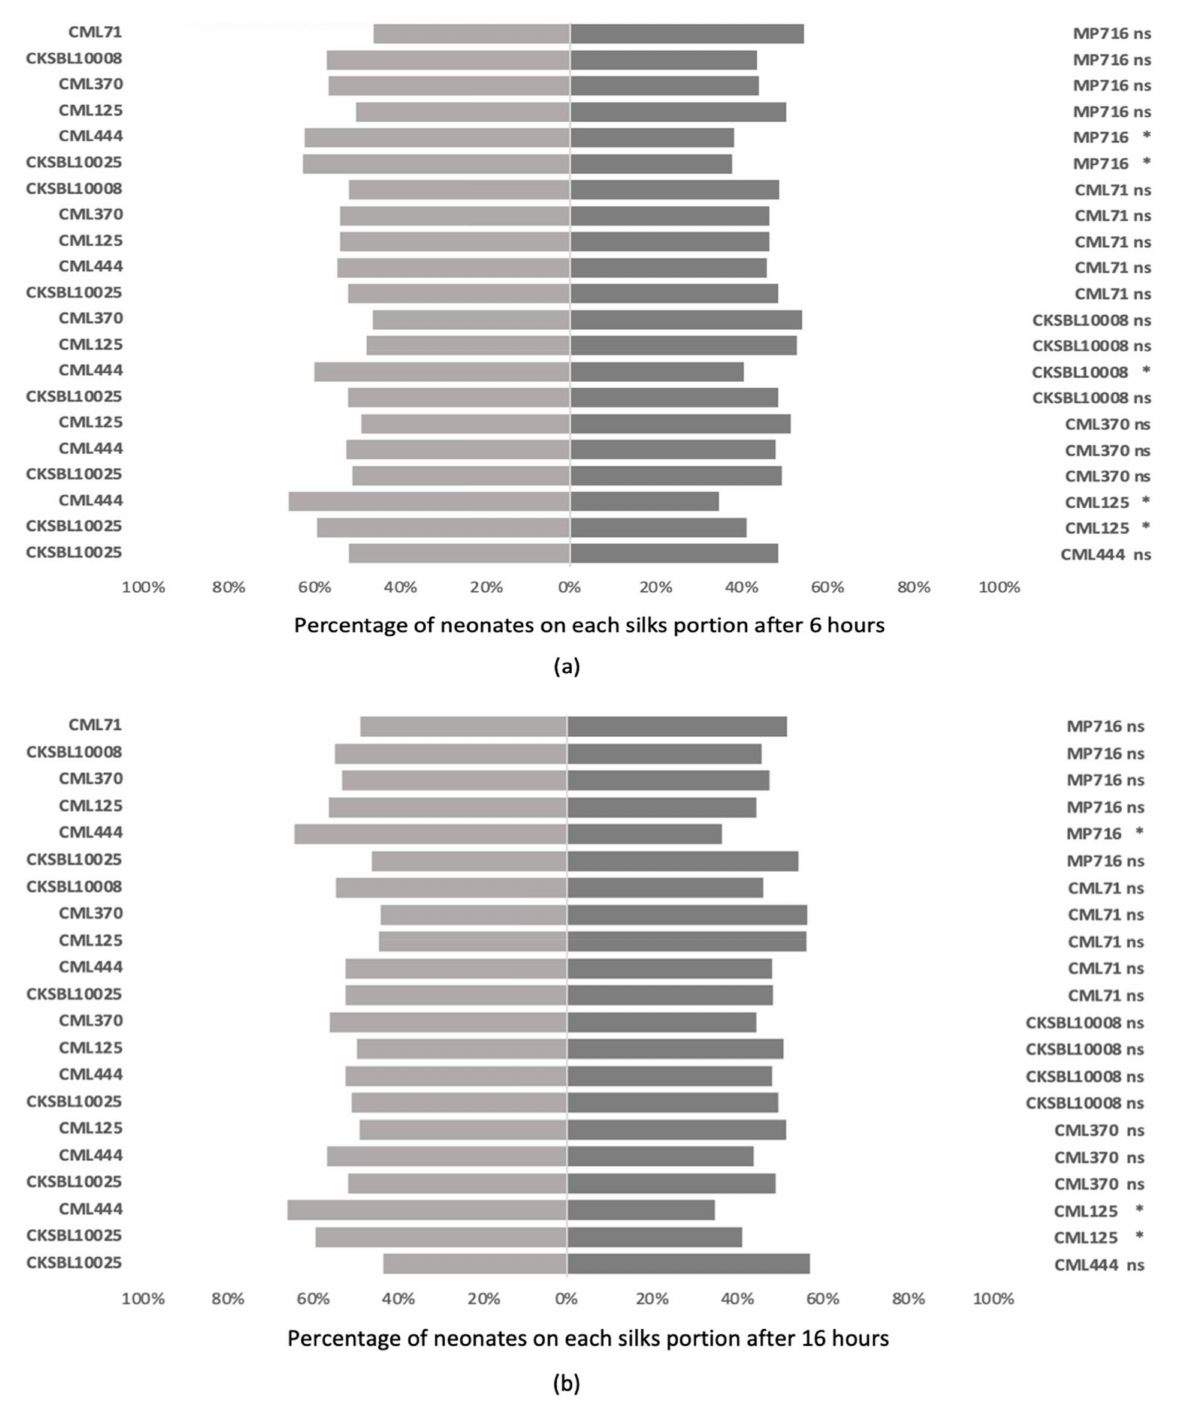
Figure 4. Mean percentage of Spodoptera frugiperda neonates found on silk of each inbred line under binary choice conditions after 6 ( a ) and 16 h ( b ) (n = 24) of bioassay between maize inbred lines in a Petri dish. Asterisks (*) represent significant differences and (ns) represent no significant differences at 5% level (Wilcoxon rank sum